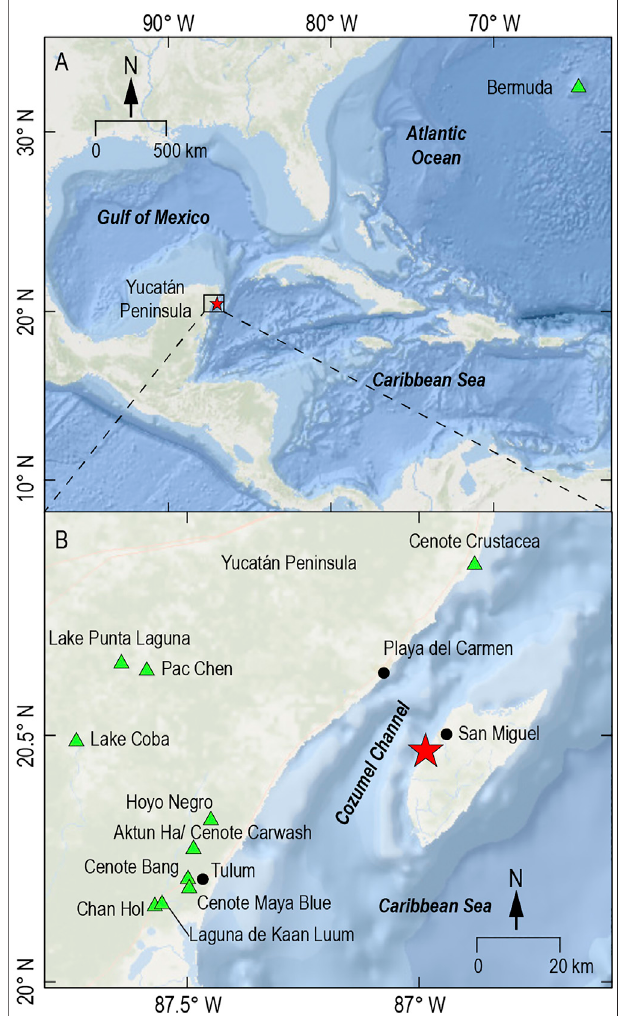
FIGURE 1 | Cozumel Island located east of the Yucatán Peninsula, Mexico.AerolitoCave(redstar)islocatedonthewestcoastofCozumel.Other common research sites in karst subterranean estuariesare also shown (green triangles) in Bermuda (Cresswell and van Hengstum, 2021) and the Yucatán region, such as Hoyo Negro (Kovacs et al., 2017), Carwash (Gabriel et al., 2009),Yax Chen (Collins et al., 2015),Maya Blue (Pohlman et al., 1997), and Cenote Bang (Brankovits et al.,